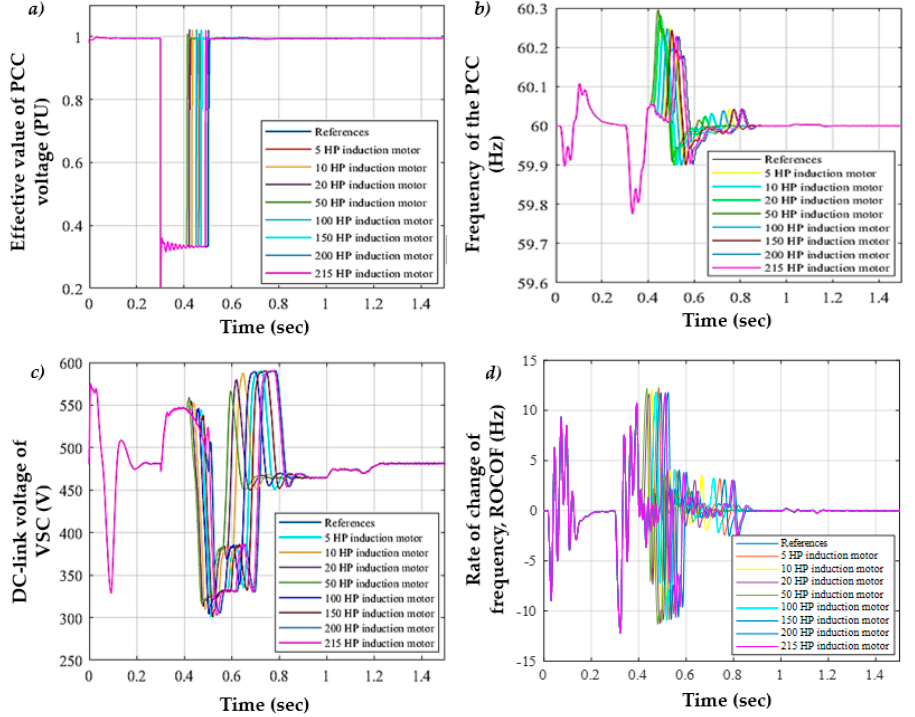
Figure 11. Simulation case of switching the electric motor, ( a ) the effective value of PCC voltage; ( b ) variation of the frequency at the point of common coupling; ( c ) the dc-link voltage of voltage source control; ( d ) rate of change of frequency in the starting of induction motor for non-islanding.